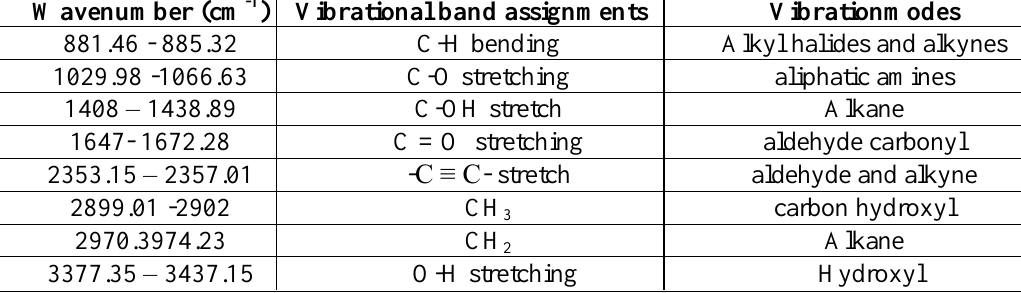
Fig. 4: FTIR spectrum, depending on the change in the number of pulses. Table 2: FTIR band positions and assignments of